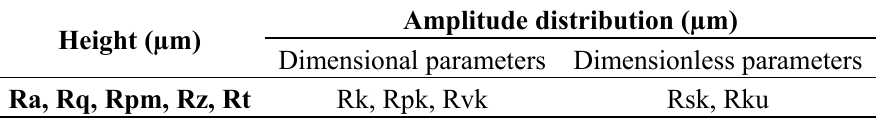
Table 1. 2D roughness